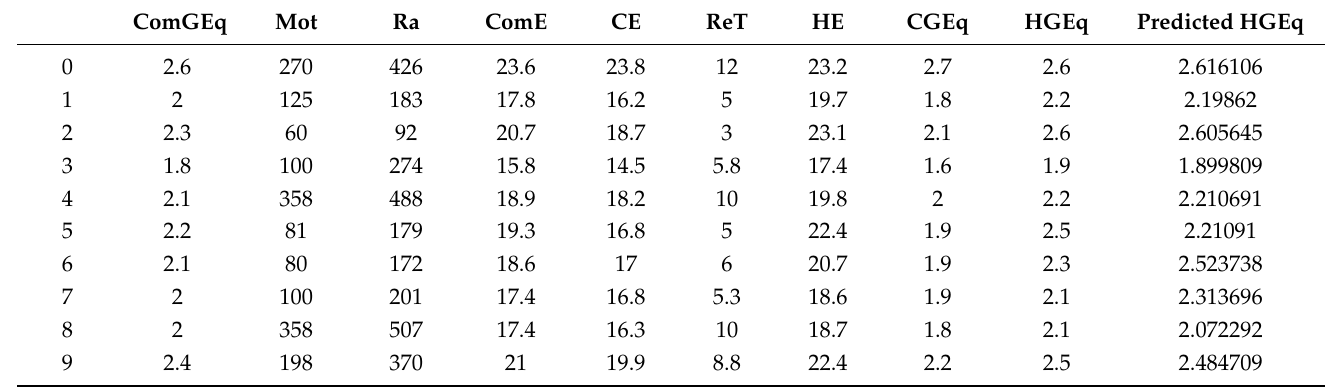
Table 7. Predicted and desired highway gasoline litre consumption equivalent.